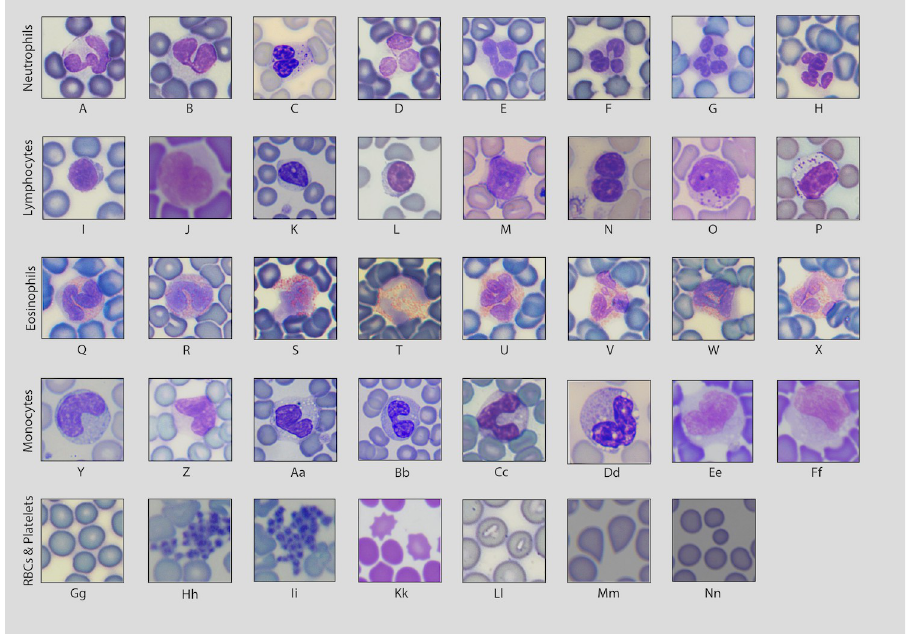
Fig 2. Images taken at 600x or 1000x magnification depicting the variable morphologies of each leukocyte lineage as well as red blood cells and platelets. (A, B) band neutrophils, (C) granular band neutrophil, (D-F) neutrophils, (G, H) hypersegmented neutrophils, (I-L) lymphocytes, (M) reactive lymphocyte, (N) binuclear lymphocyte, (O-P) large granular lymphocytes, (Q-R) band eosinophils, (S-X) eosinophils, (Y-Ff) mature monocytes, (Gg) erythrocytes, (Hh-Ii) platelet clumps, (Kk) echinocytes, (Ll) erythrocytes with low central pallor, (Mm) dacrocytes, (Nn) erythrocyte anisocytosis.